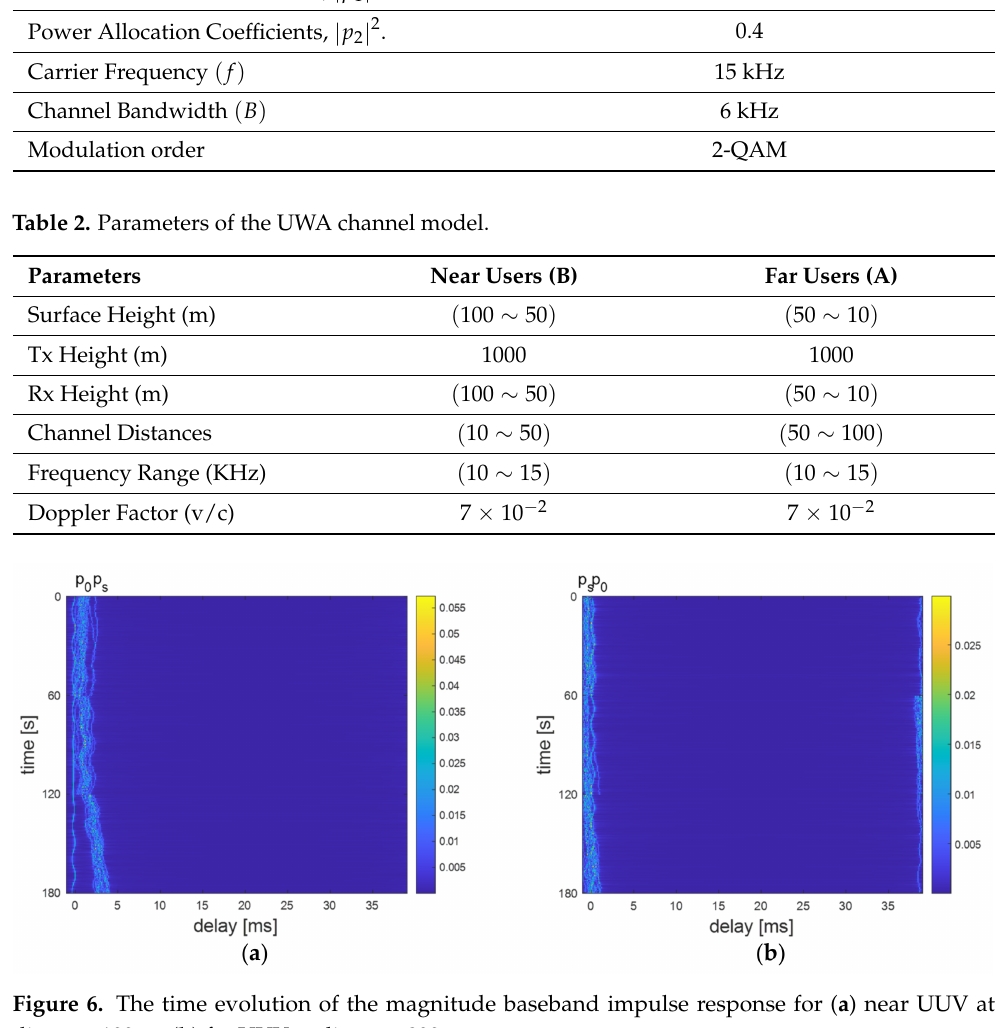
Figure 6. The time evolution of the magnitude baseband impulse response for ( a ) near UUV at distance 100 m, ( b ) far UUV at distance 800